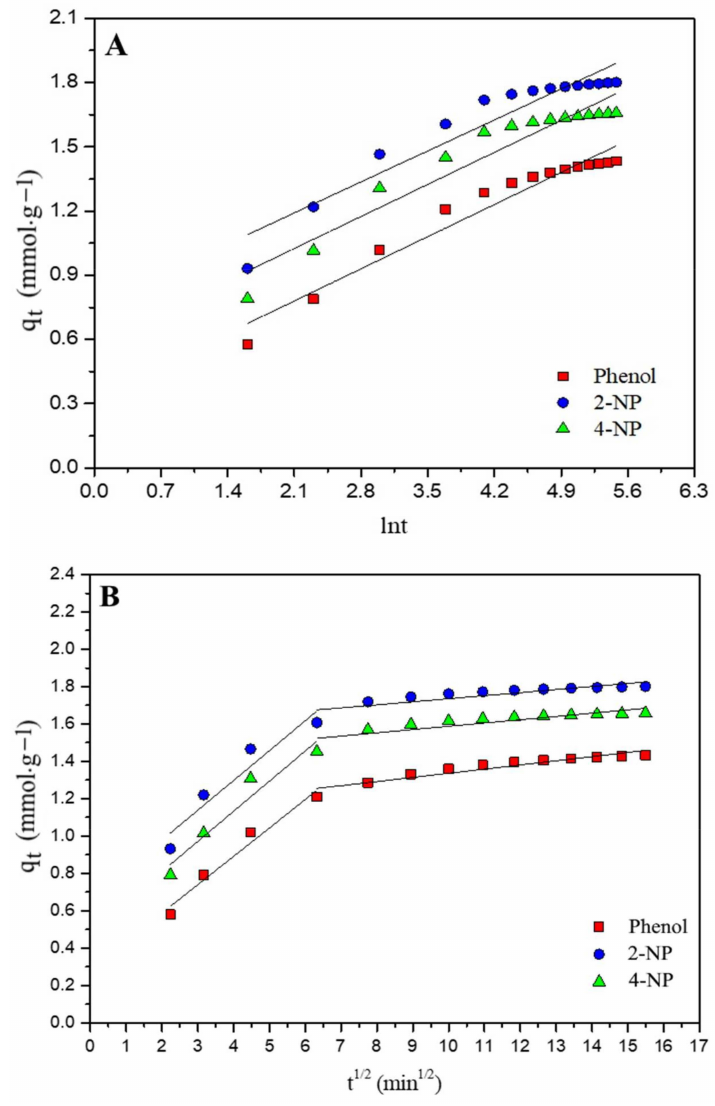
Figure 7. Elovich ( A ) and IPD ( B ) kinetic plots for the removal of phenol, 2-NP, and 4-NP by DKLAAC at 25 ◦ C with phenol concentration at 2 × 10 − 3 mol · L − 1